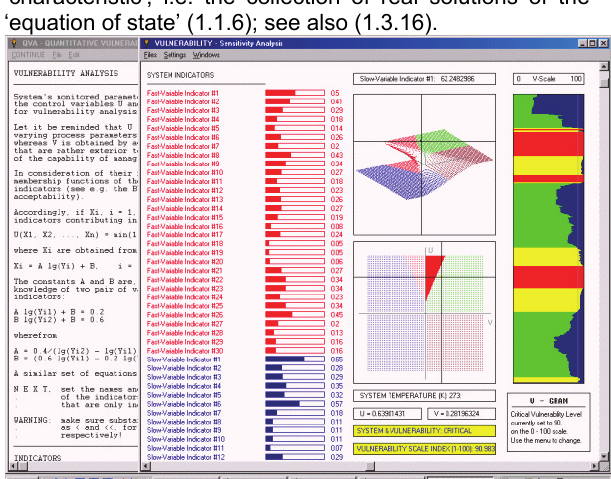
Figure 2. A computer-assisted QVA exercise. For